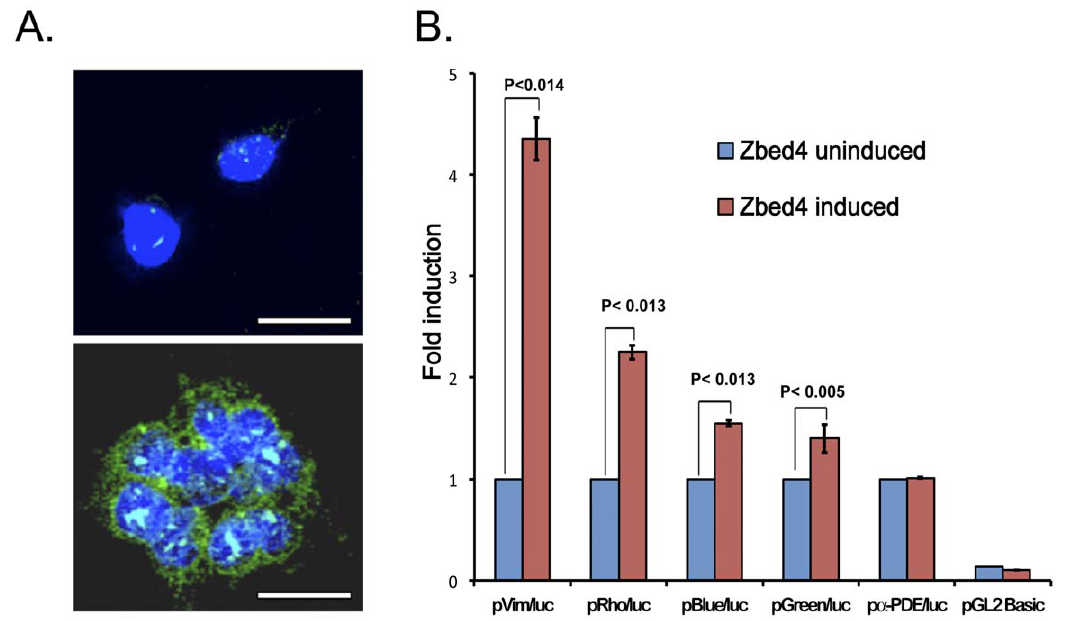
Figure 9. Zbed4 mediates transcriptional activation of several genes expressed in retina. A. Immunocytochemical detection of endogenous Zbed4 in HEK293 cells (upper image) and in HEK293 cells stably transfected with a Zbed4 expression construct (lower image). The endogenous Zbed4 in HEK293 cells is localized mainly in the nuclei (cyan) and barely detected in the cytoplasm whereas in the HEK293 stable- transfected cells Zbed4 is seen in both, the nuclei (cyan) and cytoplasm (green). DAPI was used to stain nuclei. B . Trans-activation of promoters from genes expressed in retina by Zbed4. Stably transfected HEK 293 cells expressing Zbed4 and non-transfected HEK 293 cells were used in transient transfections with luciferase reporter constructs carrying different retinal promoters. Luciferase activity was measured in the cell lysates and normalized for each transfection system to the corresponding b -galactosidase activity for each sample. The results are expressed as fold induction by Zbed4 of the mean luciferase activity of the uninduced promoter compared to that of the Vim/ luc , Rho/ luc, Blue/ luc , Green/ luc , and a -PDE/ luc reporter constructs, respectively, 6 S.D. p values for each pair of Zbed4 stimulated and non-stimulated promoters are noted above the bars.